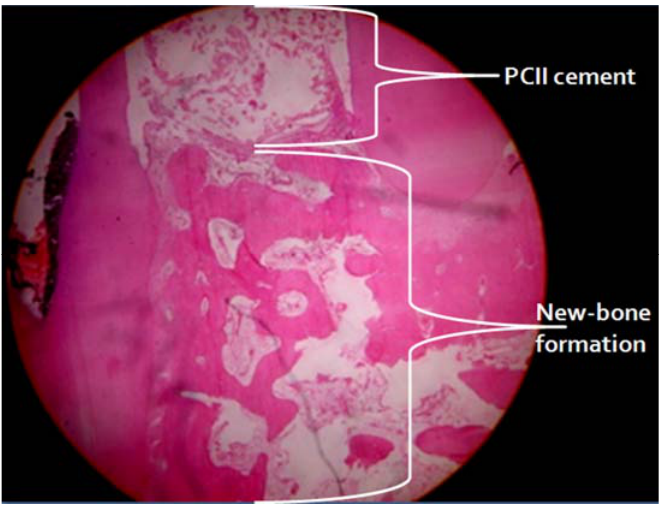
FIGURE 3 – Furcation treated with type II Portland cement. New-bone formation